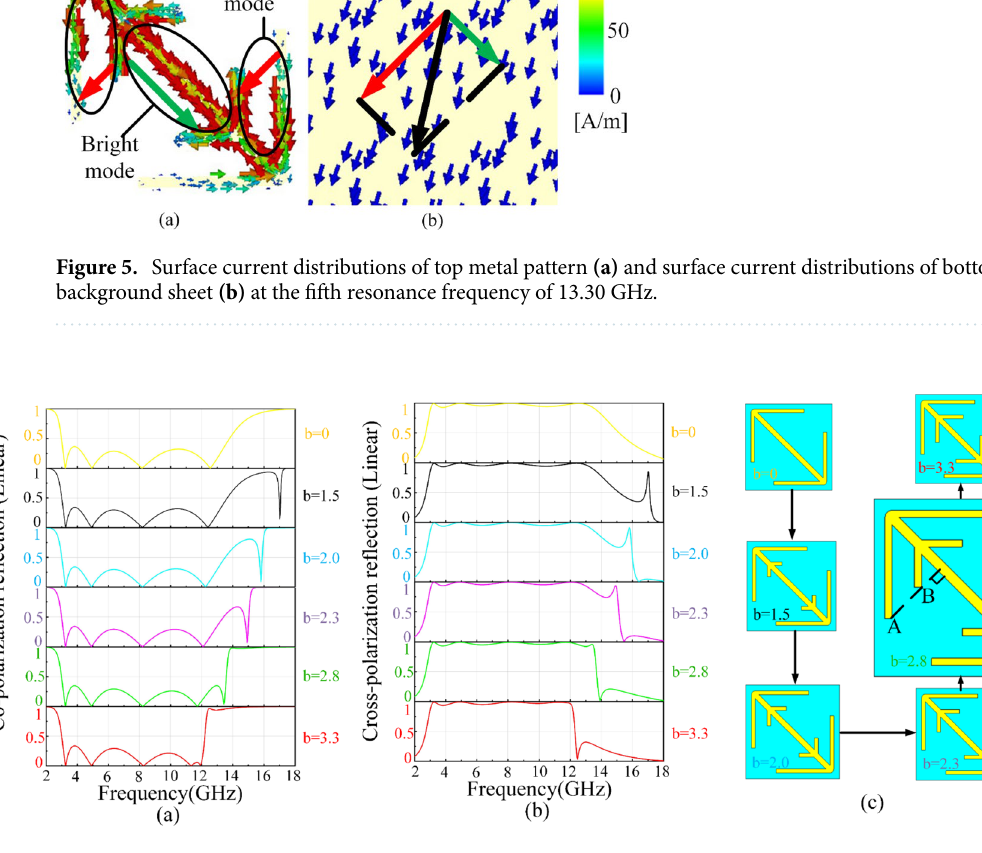
Figure 6. The linear co- (a) and cross-polarization (b) reflection when parameter b is 0, 1.5, 2.0, 2.3, 2.8, 3.3. And (c) is elevation view of structure which is changed with parameter b